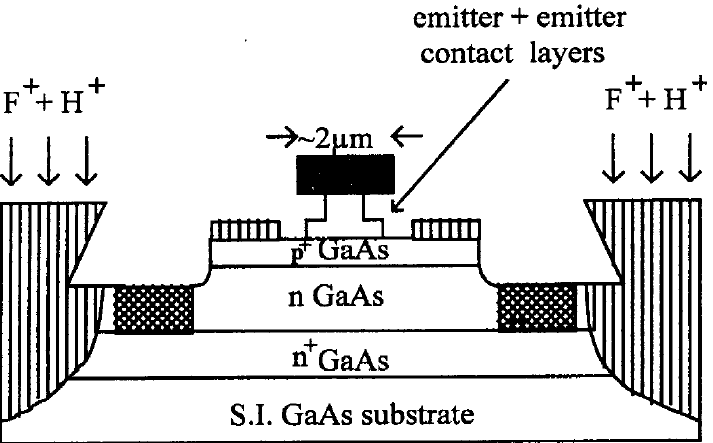
Figure 13. Schematic of implant isolated AlGaAs/GaAs HBT